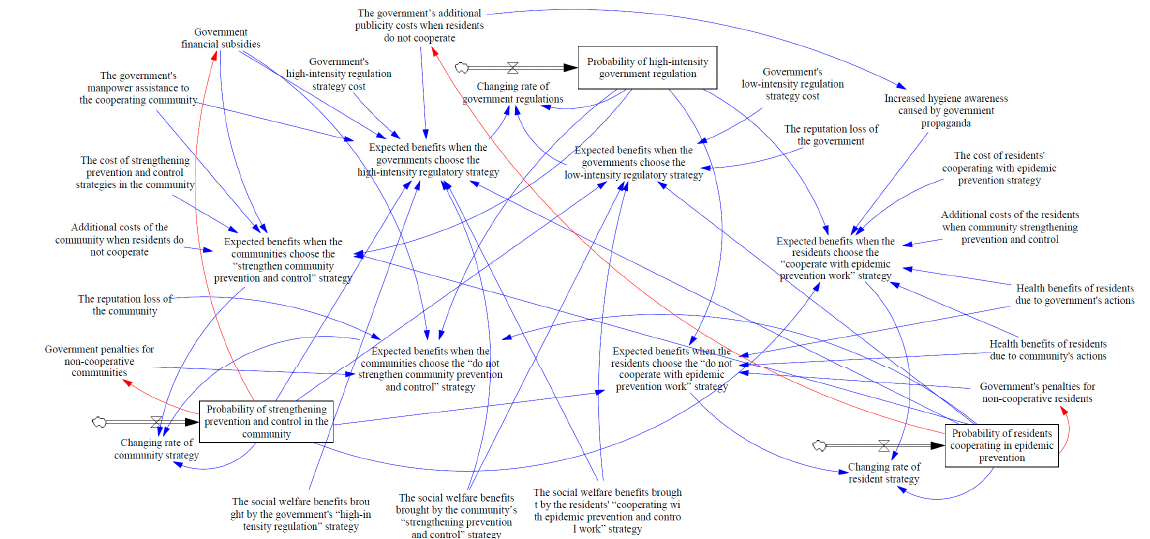
Figure 3. System dynamics stock-flow diagram of government departments, communities, and residents under the dynamic reward and punishment mechanism.